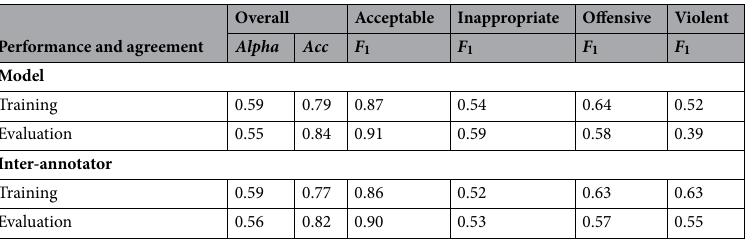
Table 3. Performance of our hate speech classification model on the training set (cross validation results) and the out-of-sample evaluation set, in comparison to the inter-annotator agreement on the same datasets. The overall performance is measured by Krippendorff’s Alpha and accuracy ( Acc ), and performance for individual classes by F 1 . Note that the performance of our model is comparable to the annotator agreement, except for the Violent class, indicated by lower F 1